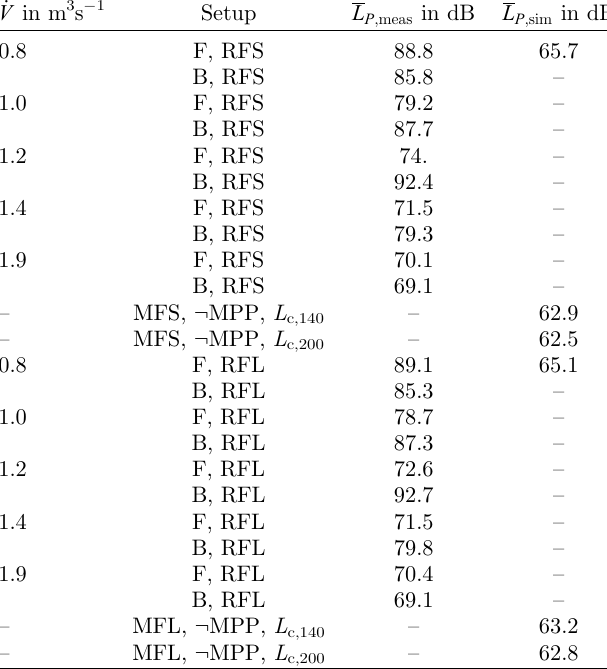
Table 1. Measured ( L P ; meas ) and simulated ( L P ; sim ) overall sound pressure level at different operating points of the fan in RFS and RFL setup; MFS ( : MPP, ... ) and MFL ( : MPP, ... ) setup simulation without MPP.